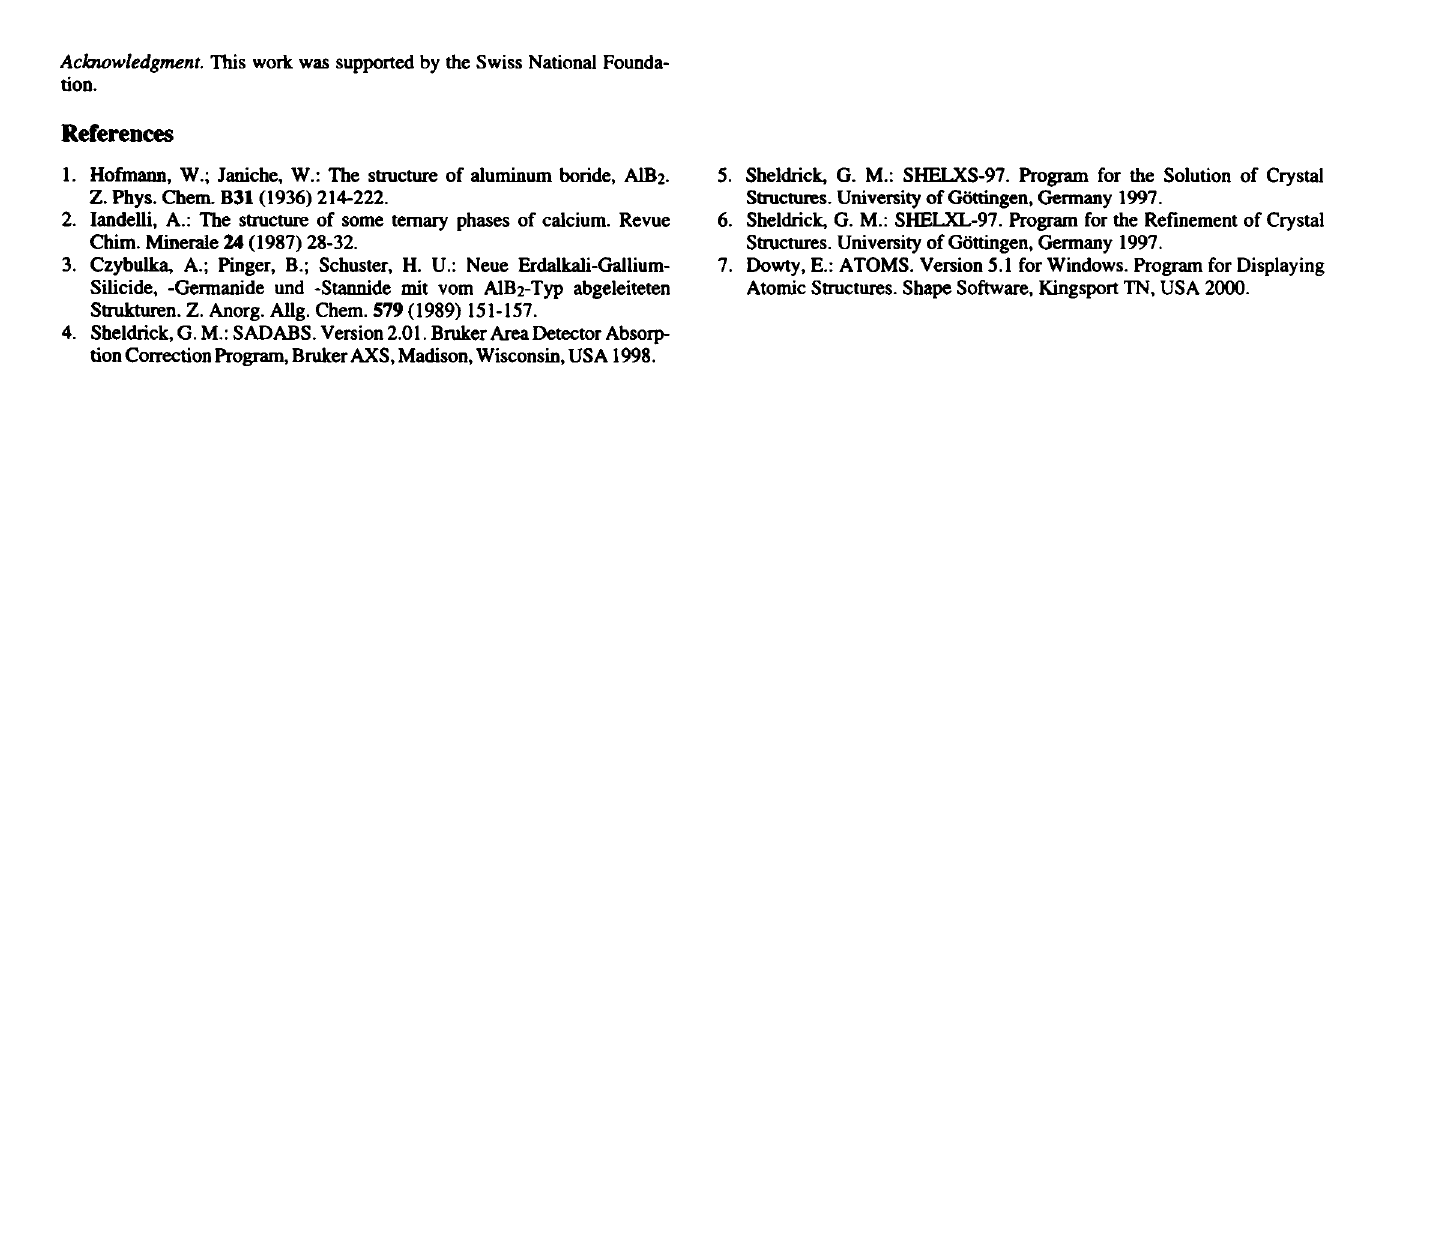
Table 4. Atomic coordinates and displacement parameters (in Â 2 ). Site